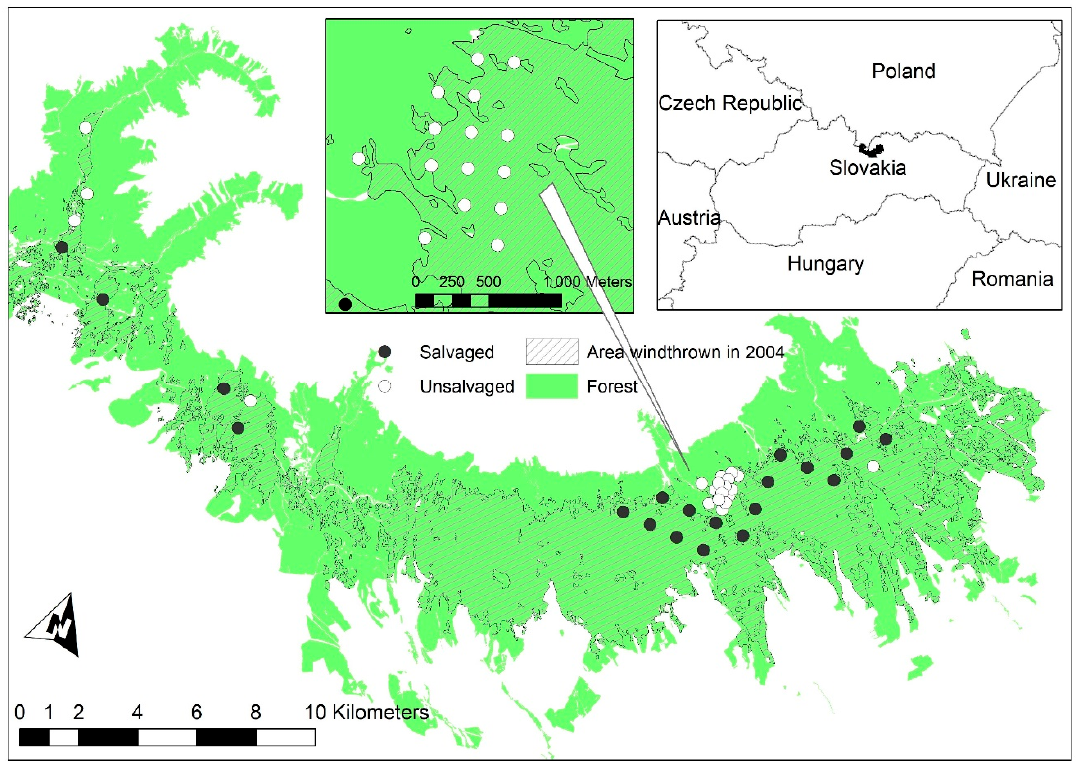
Figure 1. Forested area of the Tatra National Park (TANAP) with the area wind-thrown by the storm in November 2004 (striped) and location of monitoring spots (MSs) in salvaged (black dots) and unsalvaged (white dots) parts. Table 1. Basic site and tree characteristics of the salvaged and unsalvaged monitoring plots (the High Tatra Mts. in 2019). Monitoring Plots